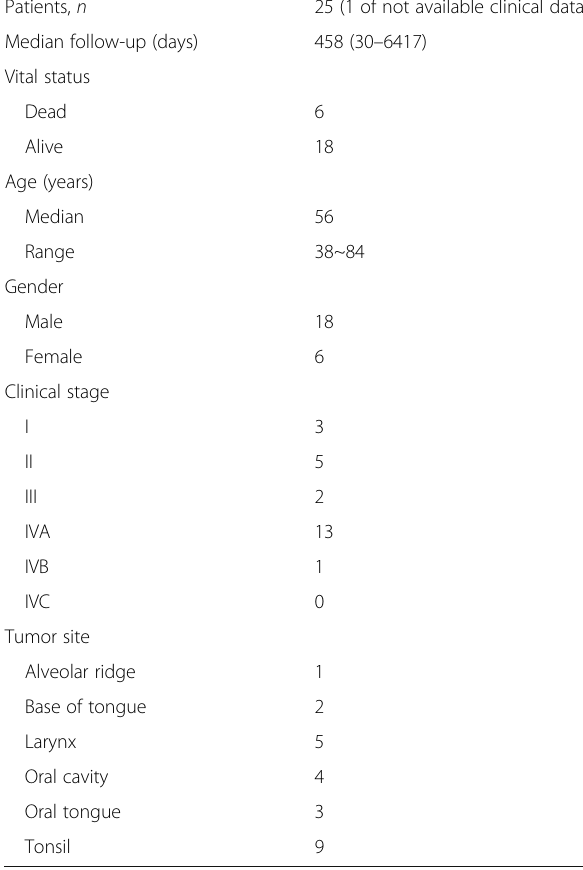
Table 1 Patients characteristics (FDG-PET) Patients,